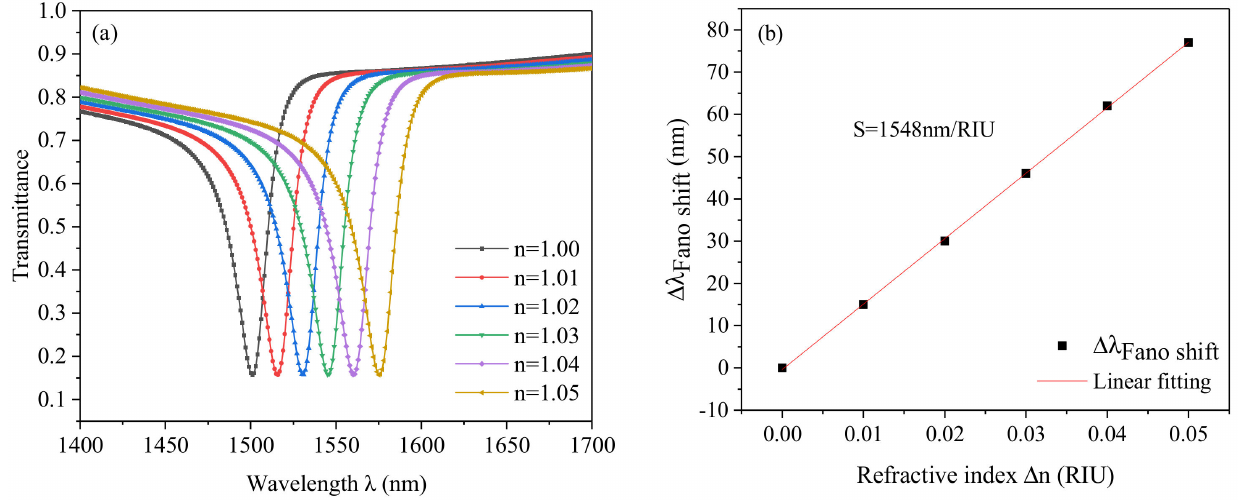
Figure 6. ( a ) Transmission spectra of the refractive indices n ranging from 1.00 to 1.05 RIU. ( b ) Linear fitting of the